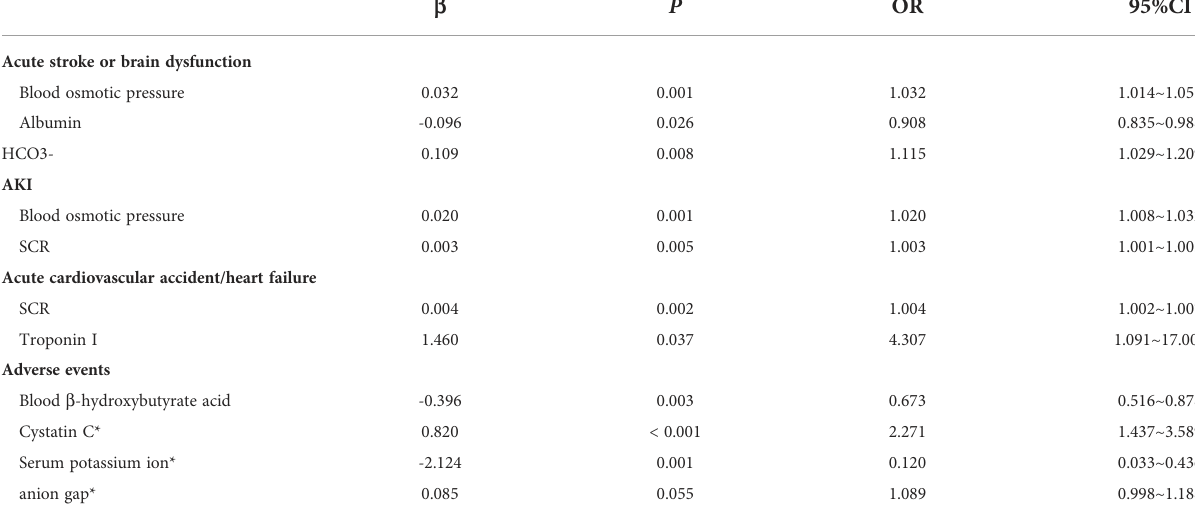
TABLE 2 Logistic regression analysis of acute organ injury at hospital and adverse events after hospital discharge. b